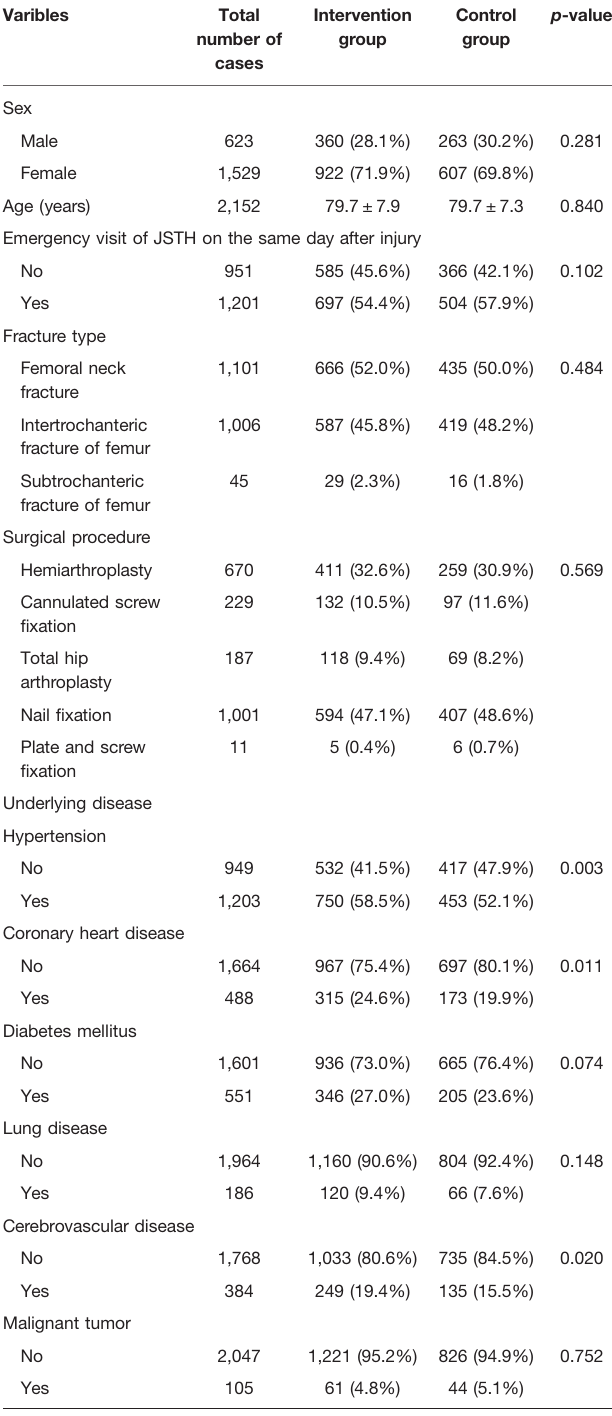
TABLE 1 | Comparison of baseline information between the two groups of patients. Varibles Total number